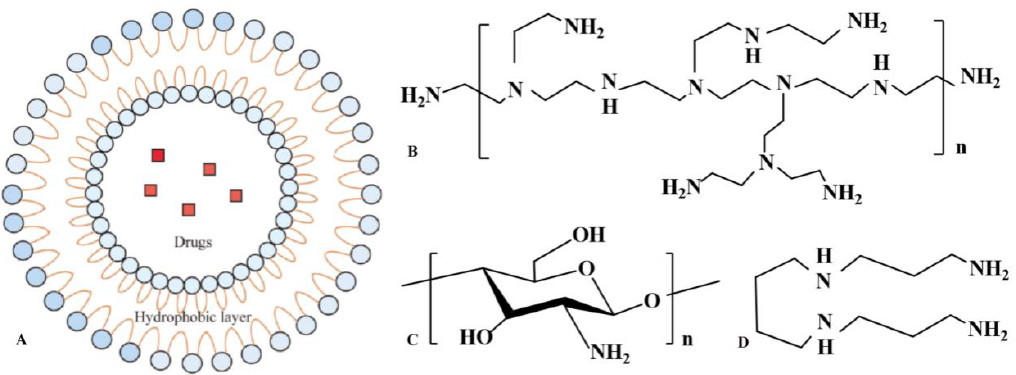
Figure 1. Well-studied nonviral vectors. ( A ): liposome; ( B ): polyethyleneimine; ( C ): chitosan; ( D ): spermine.